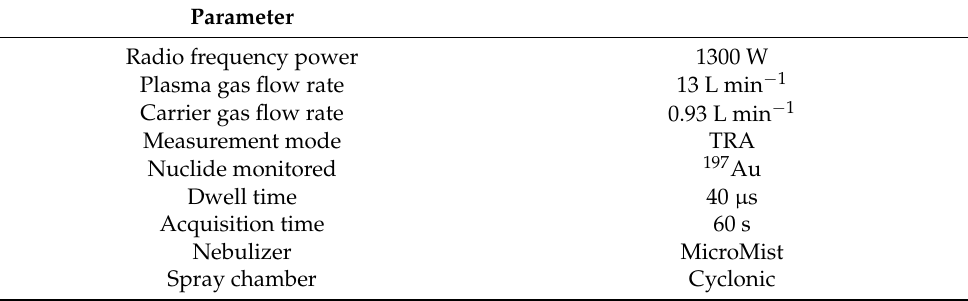
Table 2. ICP-MS instrument settings and data acquisition parameters.